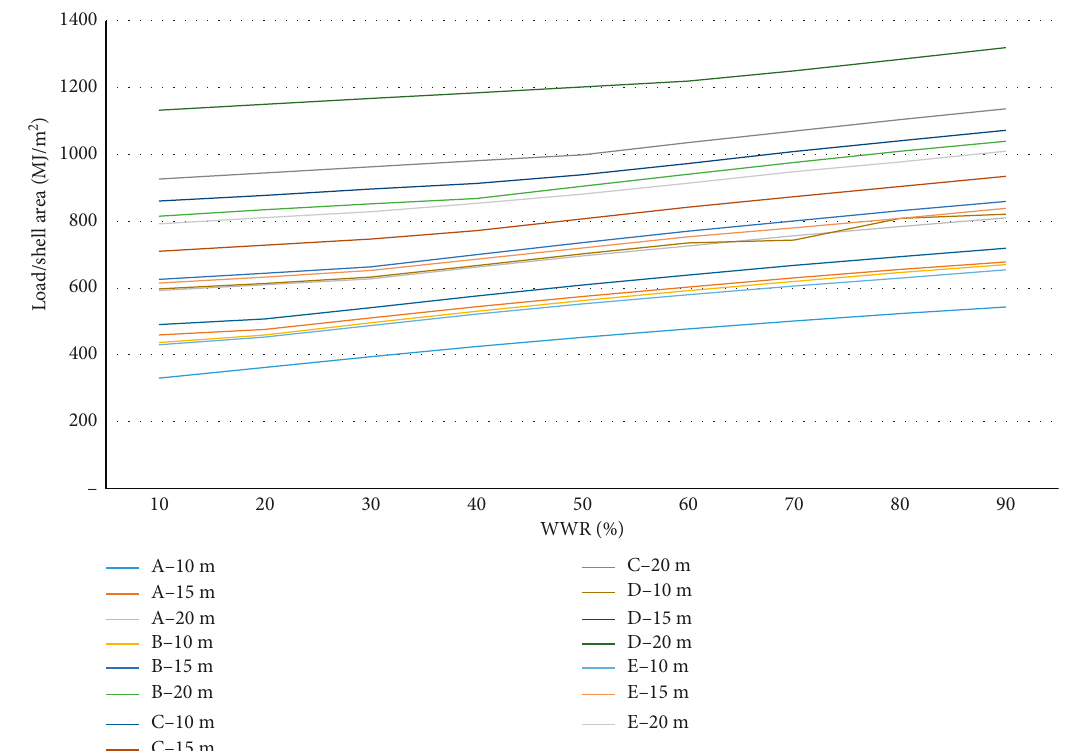
Figure 7: Energy consumption per shell area by tower type and scale (MJ/m 2 ): residential facilities.